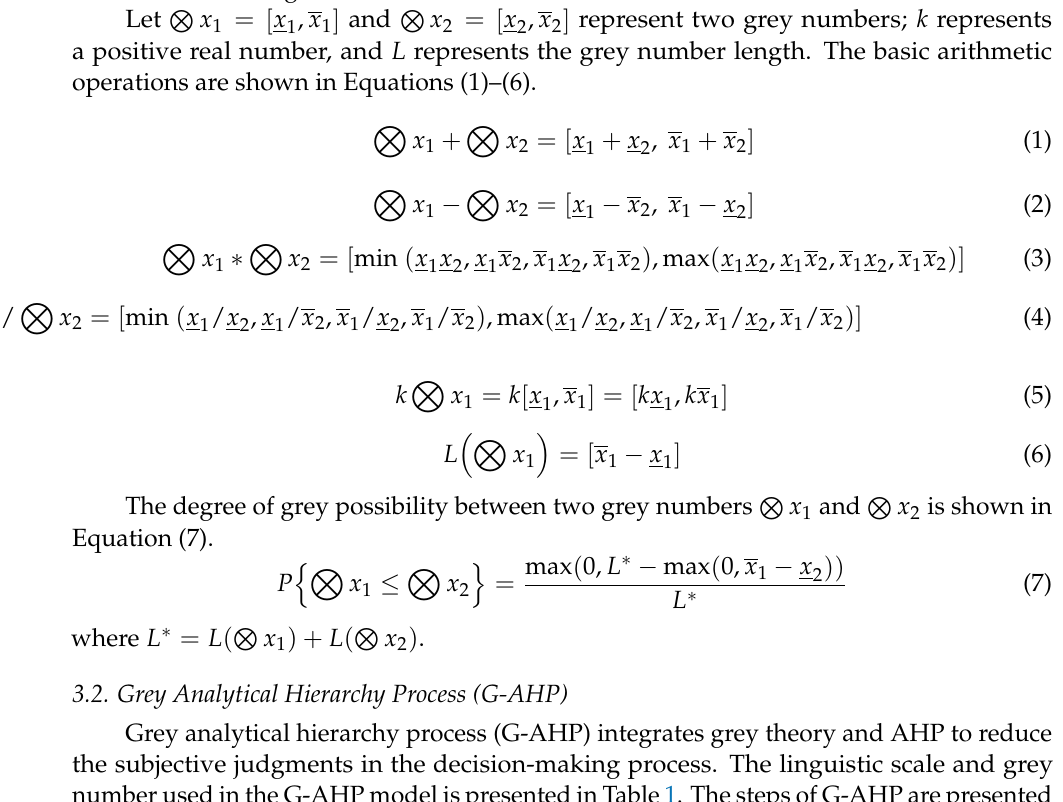
Table 1. The linguistic scale with grey number of the G-AHP model. Level Linguistics Scale Grey Number 1 Equivalent Importance (EI) [1,2] 3 Medium Importance (MI) [2,4] 5 Strong Importance (SI) [4,6] 7 Very Strong Importance (VSI) [6,8] 9 Extreme Importance (EMI)